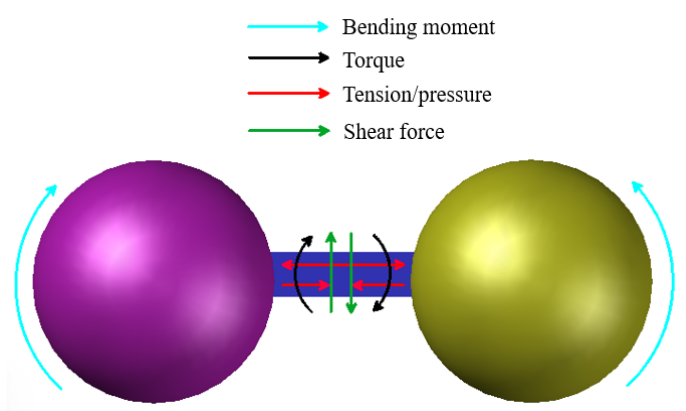
Figure 2. Interaction forces between Hertz-Mindlin particles.